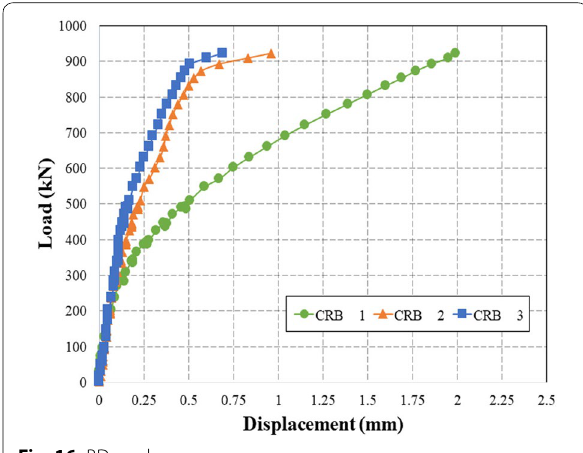
Fig. 16 BD crack curve.